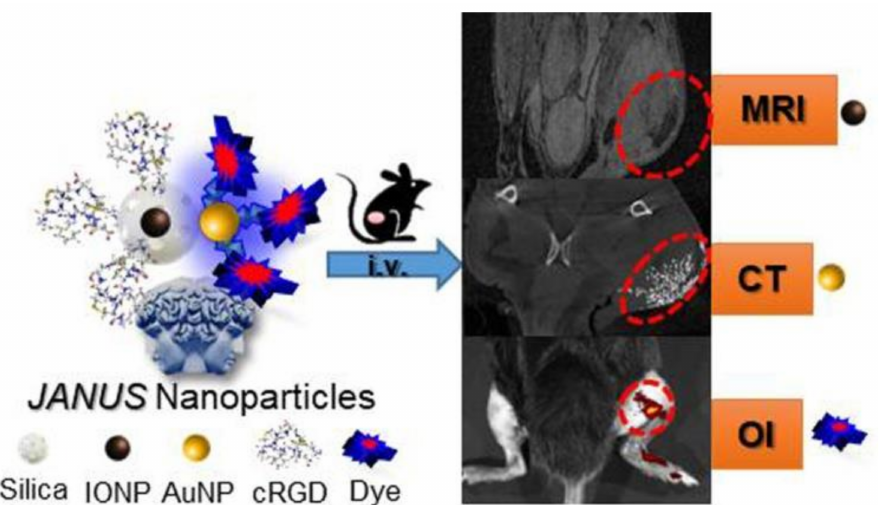
Figure 11. Janus nanoparticle for multimodal molecular imaging of solid cancer by MRI, CT, and op- tical imaging. Adapted with permission from [97], Copyright 2018 American Chemical